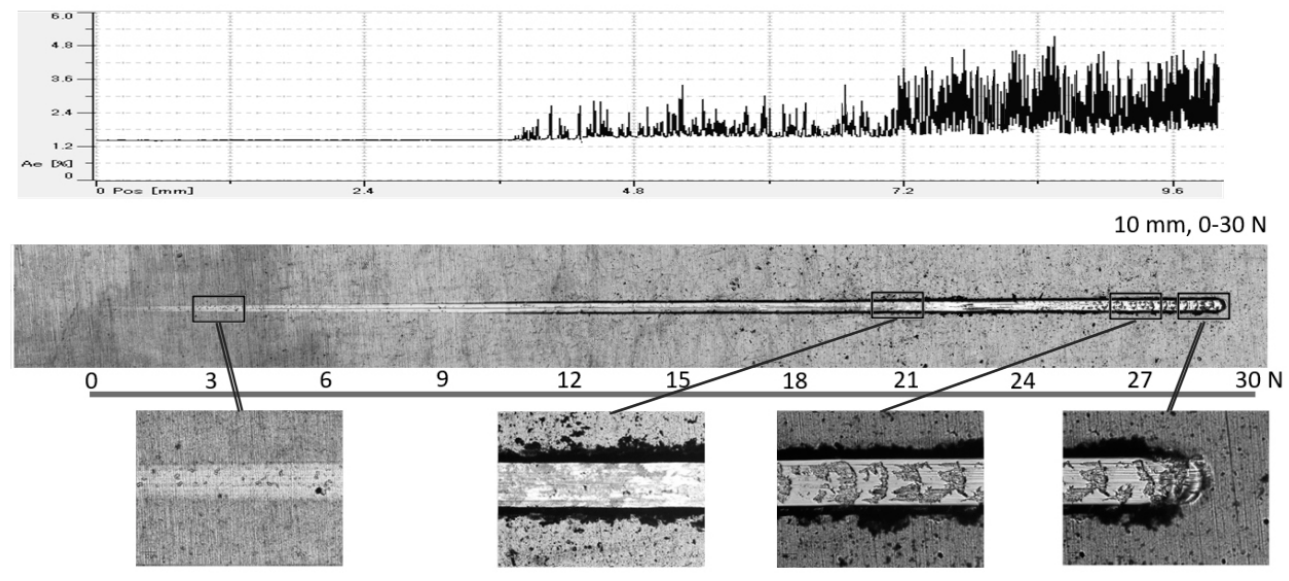
Figure 7. Scratch track observed in the surface of the film after scratch testing experiment from 0 to 30 N.